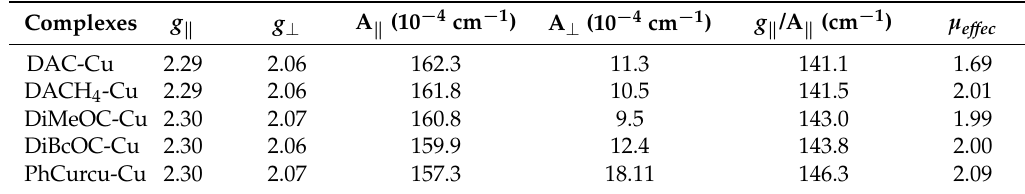
Figure 2. Spectra EPR of 6 ( a ), 7 ( b ), 8 ( c ) 9 ( d ), and 10 ( e ). Table 3. EPR spectra data of copper complexes 6 – 10 .